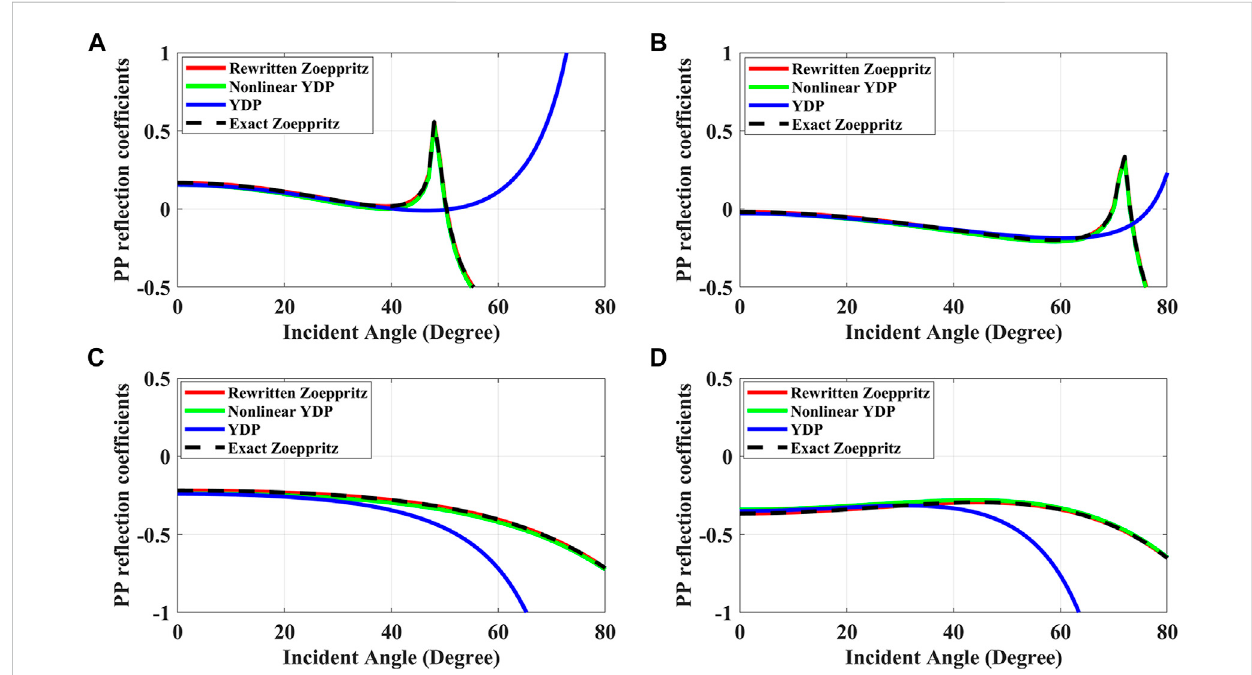
FIGURE 1 ComparisonoftheP-to-Pwavere fl ectioncoef fi cientscalculatedbythenewlyrewrittenZoeppritzequation(redcurves),theexactZoeppritzequation(black dotted curves), the YPD approximation (blue curves), and the non-linear YPD equation (green curves) for four models [ (A) I (B) II (C) III (D) IV].